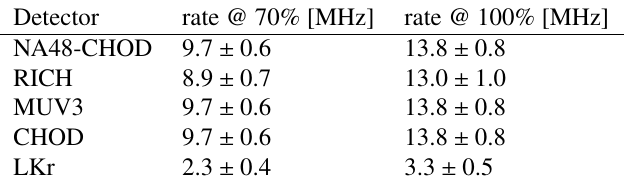
Table 1. Rate of primitives coming from detectors to L0TP. The rate has been evaluated considering